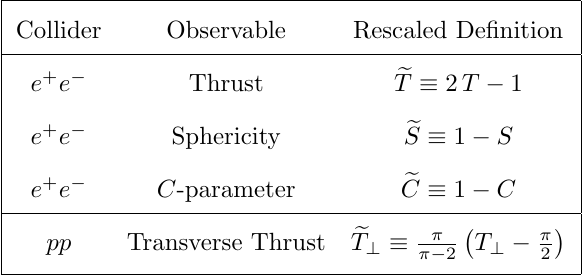
Table 2 . Previous event shape observables and their rescaled variants. Like event isotropy I , the rescaled event shapes range from [0,1], where 0 is perfectly